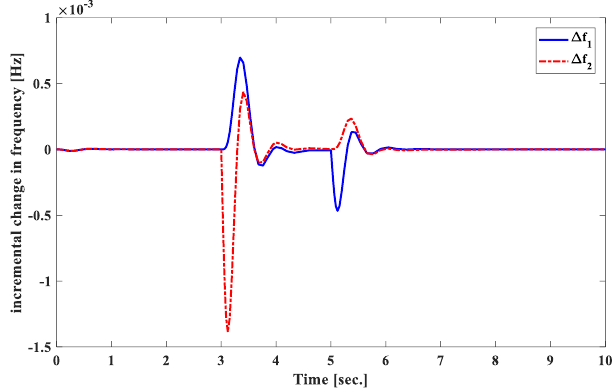
Figure 2. Frequency deviations [Hz] of the control areas 1 and 2 with matched disturbances.